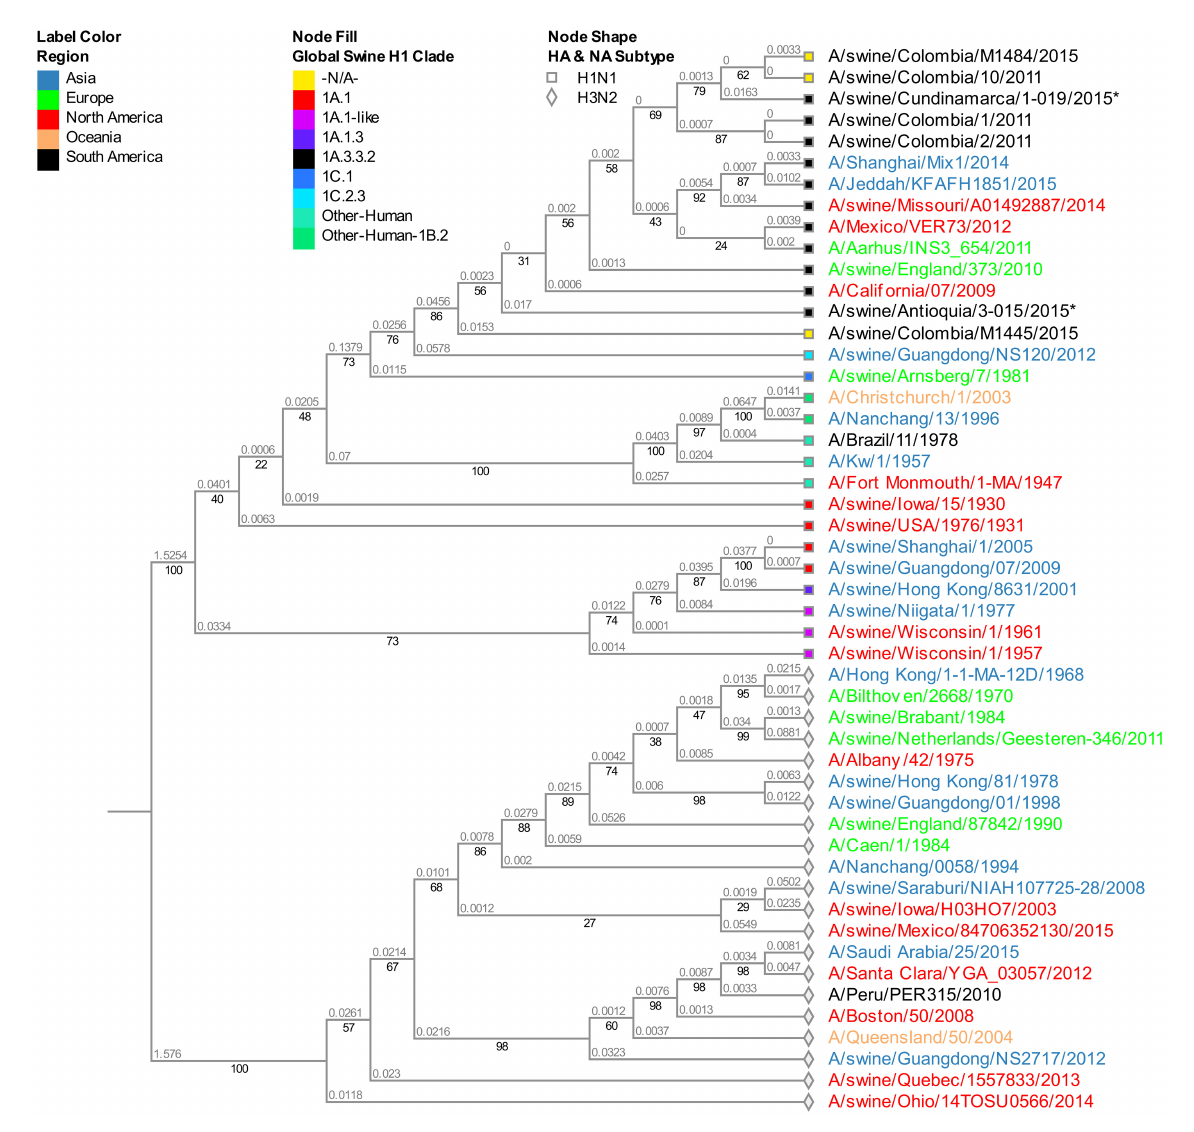
FIGURE2 Phylogenetic analysis for NA gene of swine influenza A virus. Phylogenetic tree was generated using RAxML program for maximum likelihood-based inference. The reliability of the trees was inferred by bootstrap analysis with 1,000 replications. The tree was constructed with representative sequences from human and swine H1N1 classical and H1N1pdm09, as well as human and swine H3N2. Colombian isolates included on this study are labeled with